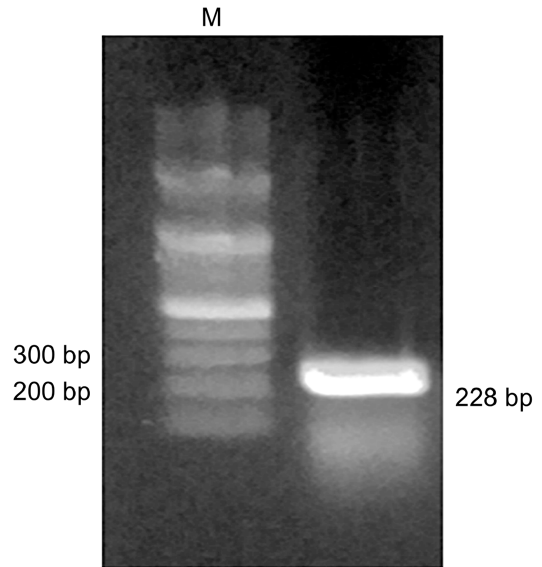
Figure 2. Agarose gel electrophoresis analysis of the NT-proBNP DNA fragment amplified via PCR. Lane M indicates the 100 bp DNA ladder. Lane L contains the PCR products of NT-proBNP. The approximate size of the amplified DNA fragment was 228 bp.